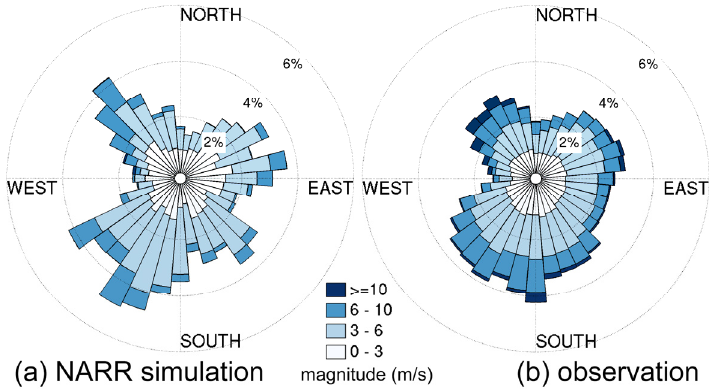
Figure 8. Wind rose plot in the hypoxia season (from May–August) in 2010: ( a ) spatially-averaged NARR data; and ( b ) observation from National Data Buoy Center and National Centers for Environmental Information.